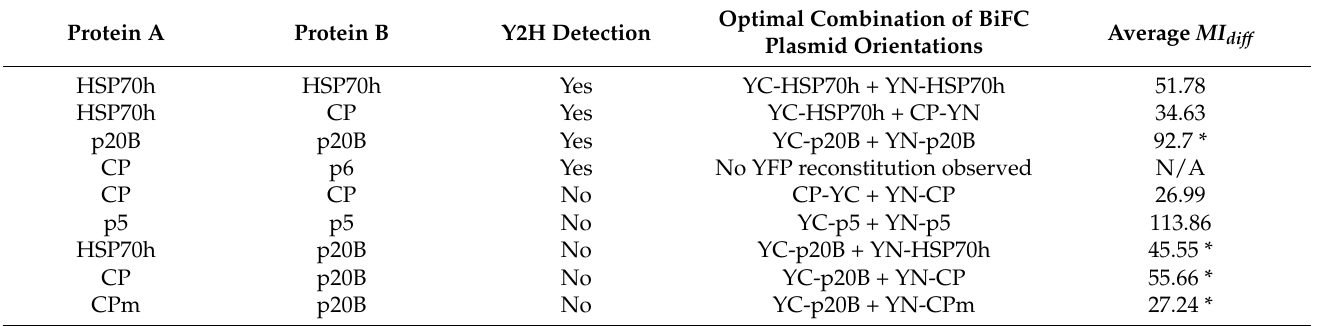
Table 1. Summary of grapevine leafroll-associated virus 3 protein–protein interactions identified using bimolecular fluorescence complementation (BiFC) and/or yeast two-hybrid (Y2H)